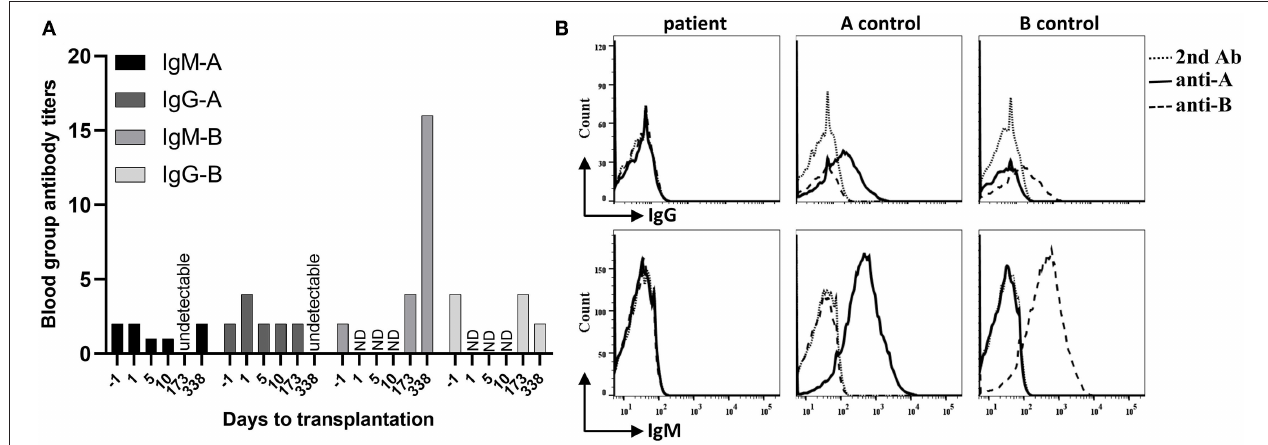
FIGURE 1 | Recipient blood group antibody titers and hemagglutinin expression on red blood cells (RBC). (A) The recipient infant ABO blood group is O, and the donor group A. Within post-operative day 338, recipient anti-donor iso-hemagglutinin-A IgM (IgM-A) titer remained at low levels (equal or less than pre-transplant level 1:2) or declined to undetectable level. Recipient anti-donor iso-hemagglutinin-A IgG (IgG-A) titer increased on post-transplantation day 1, then stabilized at the pre-transplant level (1:2) until day 173 and declined to undetectable level on day 338. In contrast, recipient’s IgM-B titer significantly increased (1:16 on day 338), and the IgG-B titer remained stable for 6 months after transplantation. ND, not done. (B) The recipient blood sample was harvested on day 338 after transplantation. After incubation with anti-A or anti-B hemagglutinin antibodies and wash, samples were incubated with fluorescein isothiocyanate (FITC) or Phycoerythrin (PE) conjugated second antibodies (2nd Ab). Cell counts were gated on CD45- whole blood cells by flow. The blood group O recipient RBCs did not express either A or B hemagglutinin. The control blood type A and B groups expressed A and B hemagglutinins on their RBCs, respectively.